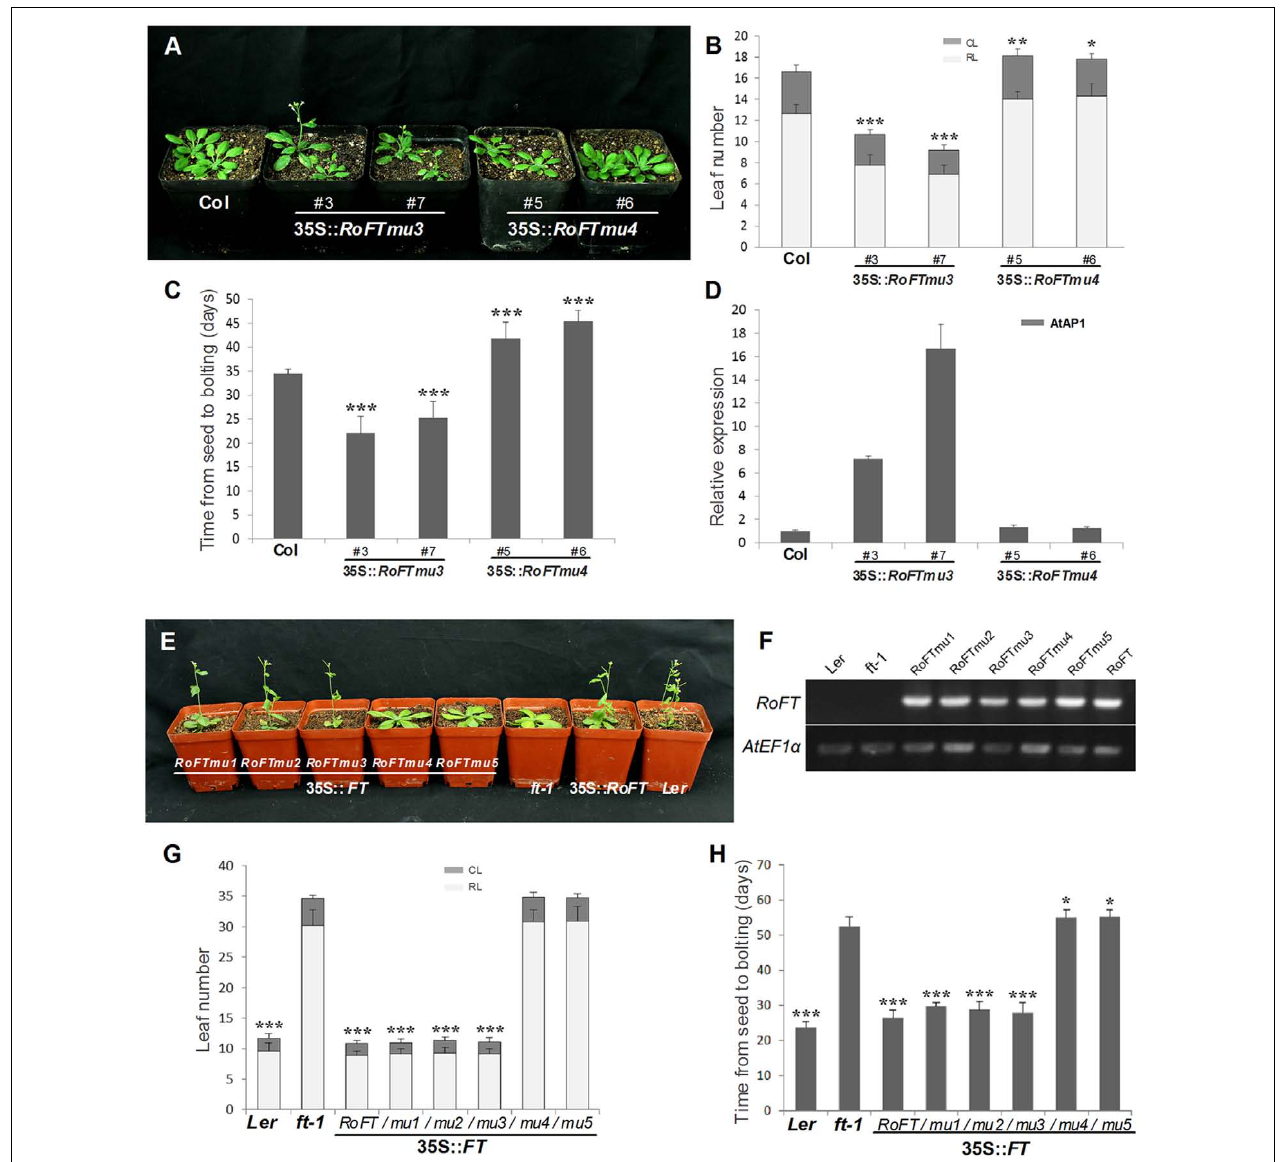
FIGURE 5 | Phenotypic analysis of ectopically expressing mutated RoFT transcripts in the Col and ft-1 Background. (A) 25-day-old 35S:: Roftmu3 (A116S) plant (center) flowering 20 days after germination which was earlier than wild-type Col (left) and 35S:: Roftmu4 (Y153C) (right). Leaf number (B) and time from seed to bolting (C) of wild-type Col and transgenic Arabidopsis plants under LD (16-h-light/8-h-dark) conditions. RL, rosette leaves; CL, cauline leaves. (D) qRT-PCR analysis of endogenous flowering genes AtAP1 in 3-week-old seedlings of wild-type Col and transgenic Arabidopsis plants. AtEF1 α was used as a reference transcript. Three biological replications were performed randomly for each transgenic line. (E) From left to right, 35S:: RoFTmu1-5 , ft-1 , 35S:: RoFT and Ler . 35S:: RoFT and 35S:: RoFTmu1-3 plants flowering 25 days after germination which were earlier than ft-1 mutant. (F) RT-PCR analysis to confirm the transgenic lines. Leaf number (G) and time from seed to bolting (H) of ft-1 and transgenic Arabidopsis plants under LD (16-h-light/8-h-dark) conditions. Asterisks show that the values are significantly different between the transgenic lines and the control ( ∗ P < 0.05; ∗∗ P < 0.01; ∗∗∗ P <